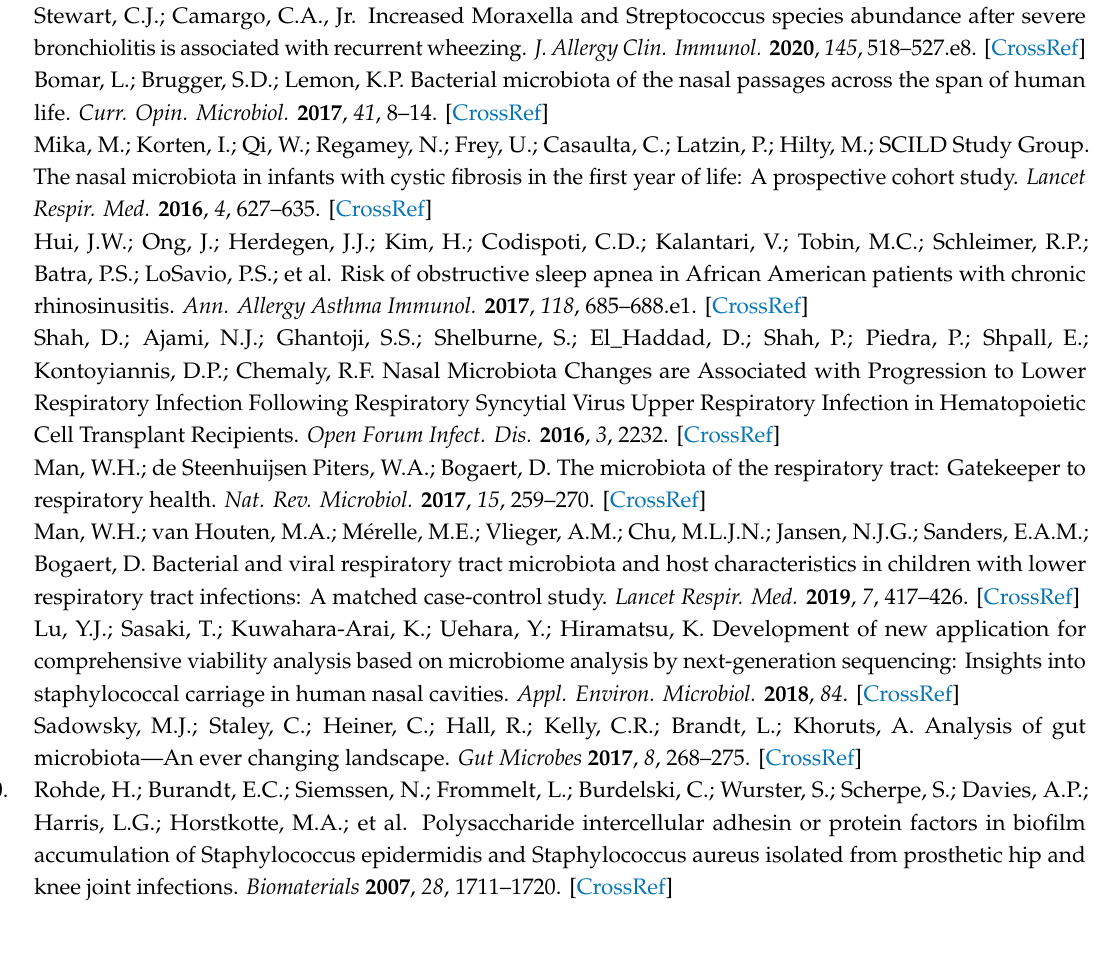
Figure S1: Rarefaction curves of sequenced nasal swab samples, Figure S2: Principle coordinate analysis on Illumina and nanopore nasal microbiota profiles. Figure S3: Re-basecalling of nanopore sequence reads derived from nasal